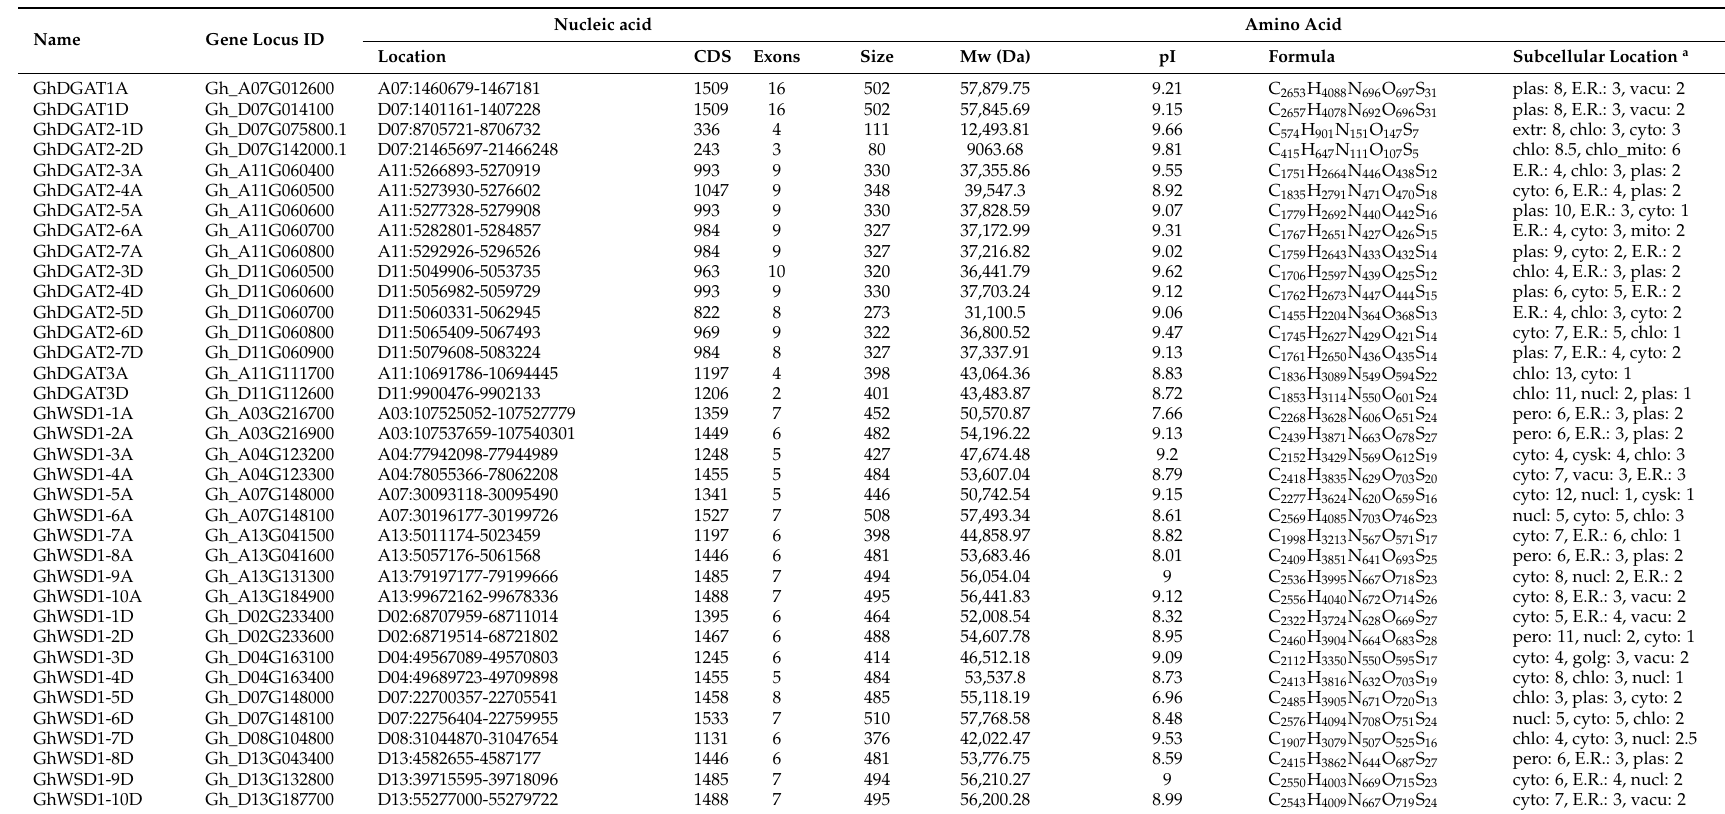
Table 1. Characterization of GhDGAT and GhWSD1 genes in G. hirsutum . a The top three most possible subcellular localizations of GhDGAT and GhWSD1 genes are shown. Abbreviations: chlo: chloroplast; cysk: cytoskeleton; cyto: cytoplasm; E.R.: endoplasmic reticulum; extr: extracellular; mito: mitochondrion; nucl: nucleus; pero: peroxisome; plas: plastid; vacu: